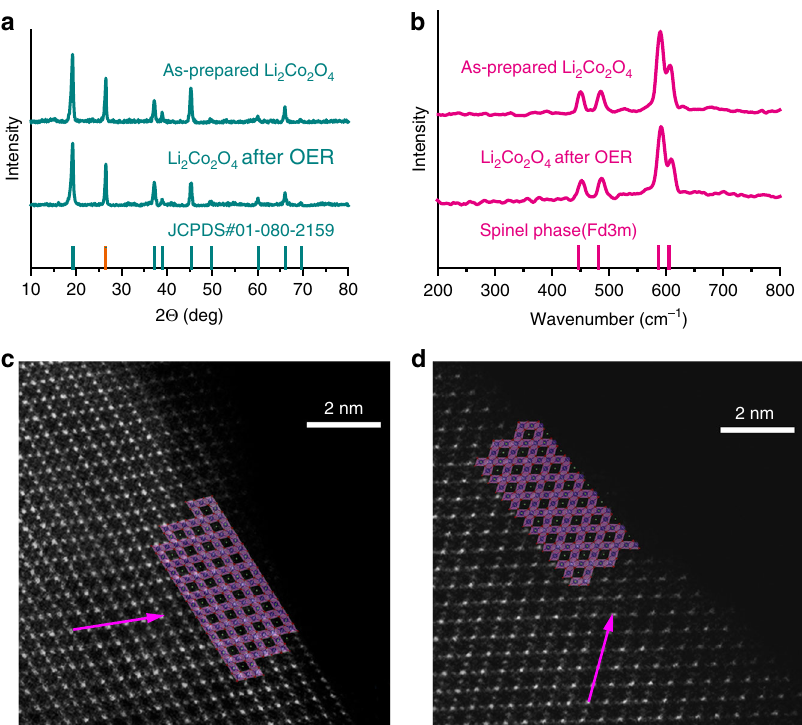
Fig. 4 Structural characterizations of Li 2 Co 2 O 4 . a XRD patterns of Li 2 Co 2 O 4 as prepared and after OER. The orange line corresponds to the XRD peak of the carbon fi ber paper. b Raman spectra of Li 2 Co 2 O 4 as prepared and after OER. c HAADF-STEM images of as-prepared Li 2 Co 2 O 4 . d HAADF-STEM images of Li 2 Co 2 O 4 after OER. Both are viewed down the [110] zone axis, and the arrows are along the [1-11]